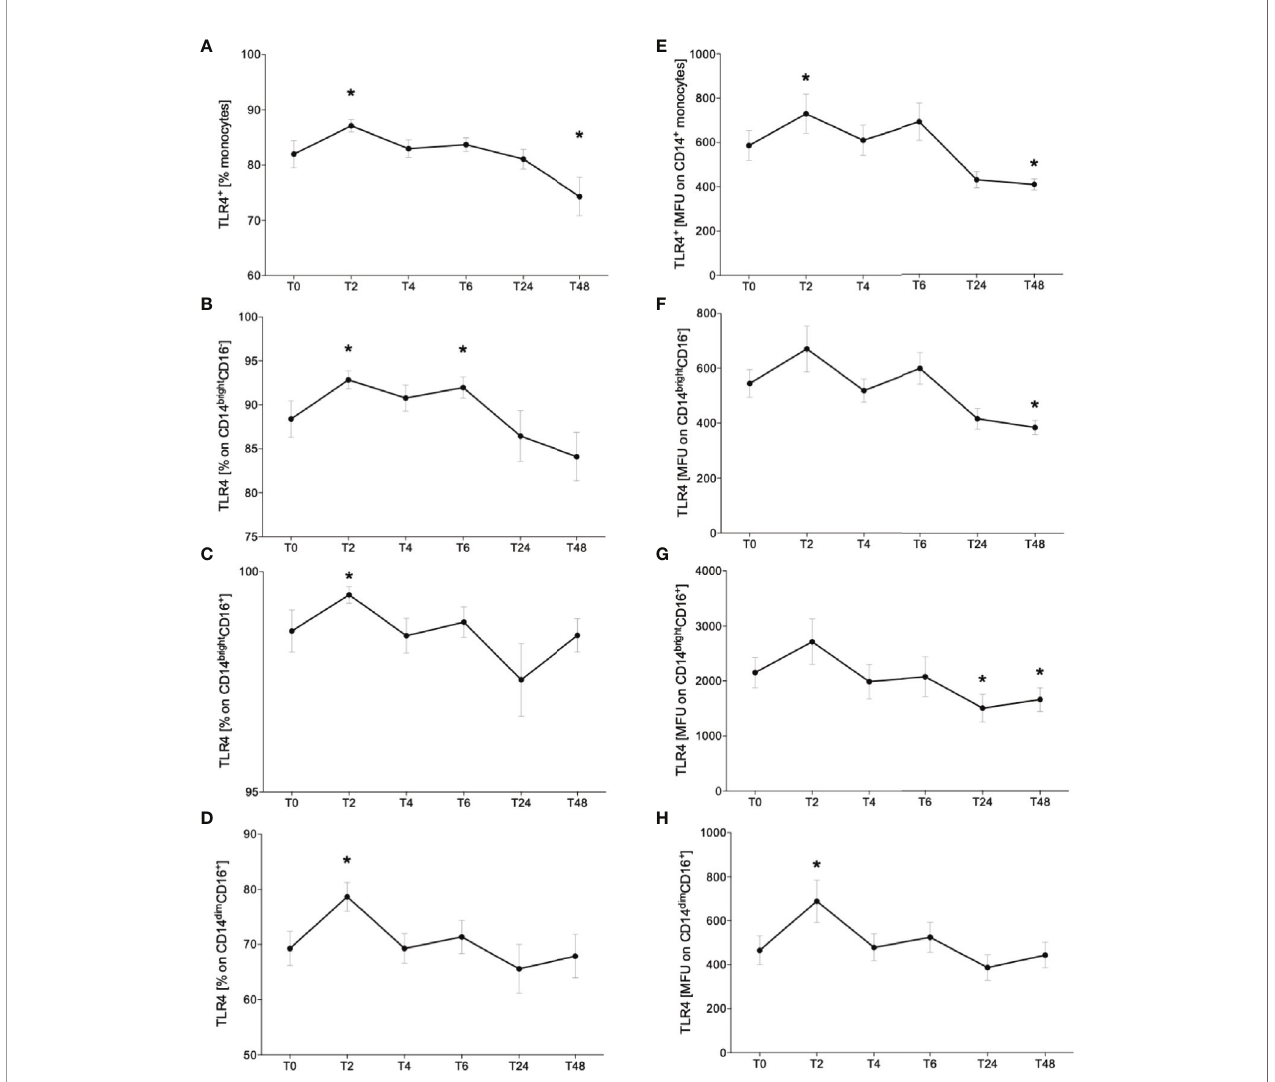
FIGURE 4 | Impact of acute alcohol intoxication on Toll-like receptor 4 (TLR4) surface presentation on monocytes. Percentage and mean intensity expression of TLR4 on CD14 + monocytes (A, E) and the classical (CD14 bright CD16 - ) (B, F) , intermediate (CD14 bright CD16 + ) (C, G) and non-classical (CD14 dim CD16 + ) (D, H) monocyte subsets were determined in blood of healthy volunteers (n=22) before (T0) and 2 (T2), 4 (T4), 6 (T6), 24 (T24) and 48 (T48) hours after starting the alcohol consumption. Data are presented as mean ± standard error of the mean. *p < 0.05 vs .